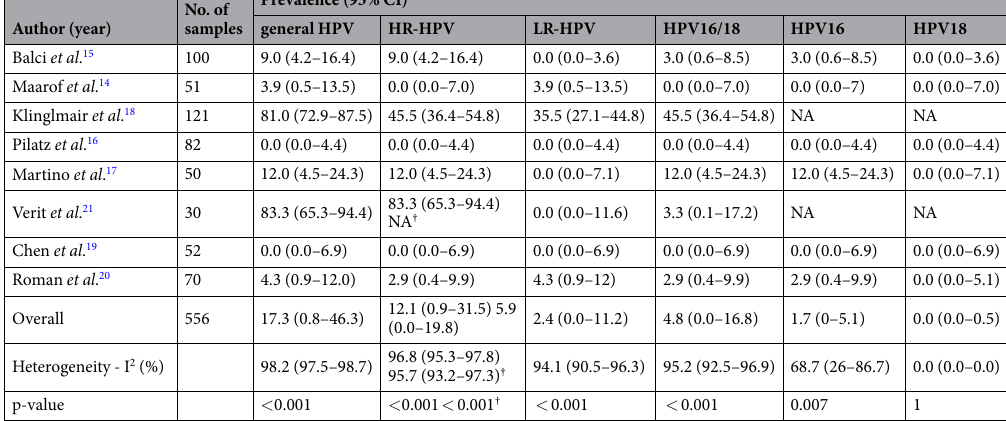
Table 3. Estimated prevalence by the random-effect model. NA, not available; LR, low-risk; HR, high-risk; CI, confidence interval. † This value is generated by omitting the study of Verit et al ., which was proved to be outlier by Galbraith plot. a The process of meta-analysis with prevalence data: 1) transform the prevalence into a quantity (Freeman-Tukey variant of the arcsine square root transformed proportion), 2) calculate the pooled prevalence as the back-transformation of the weighted mean of the transformed prevalences using DerSimonian-Laird weights assuming the random-effect model.